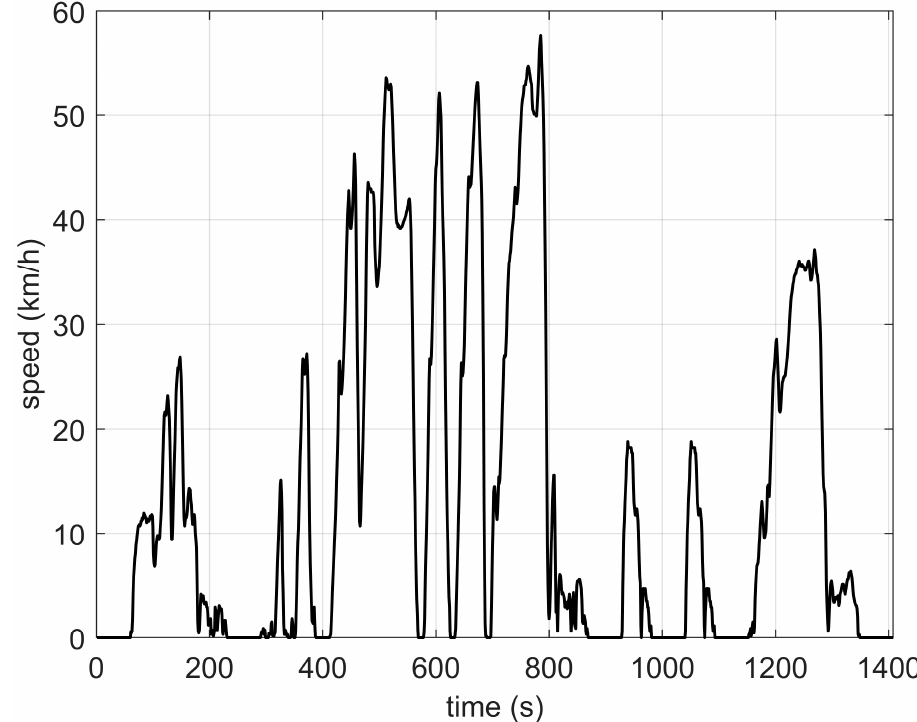
Figure 9. The speed profile of the vehicle.